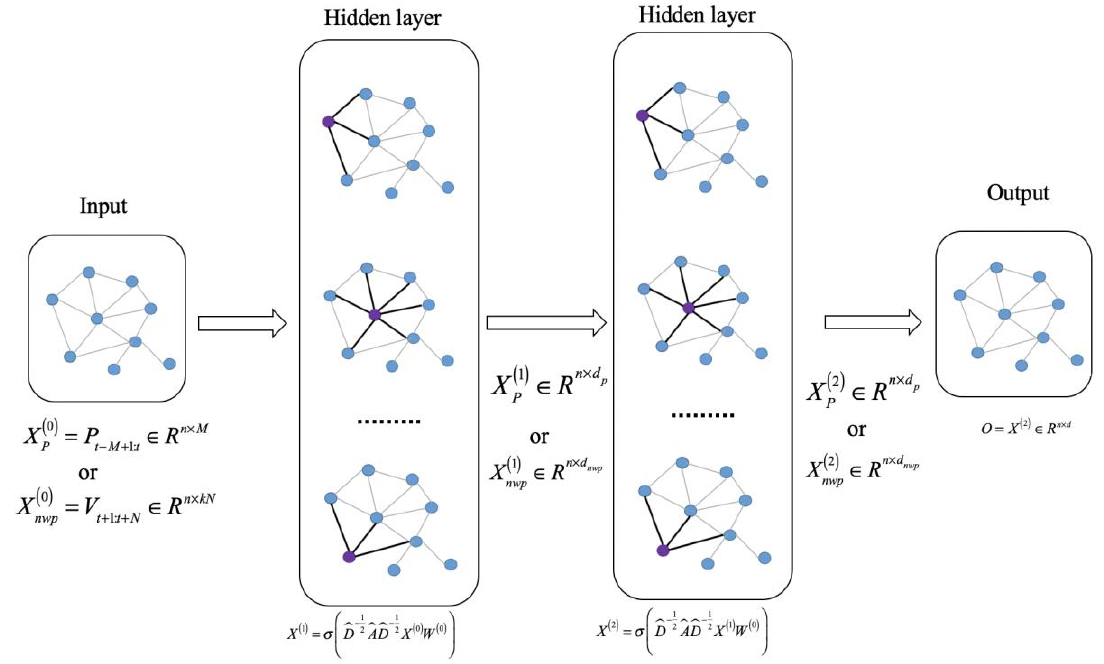
Figure 3. Graph convolutional